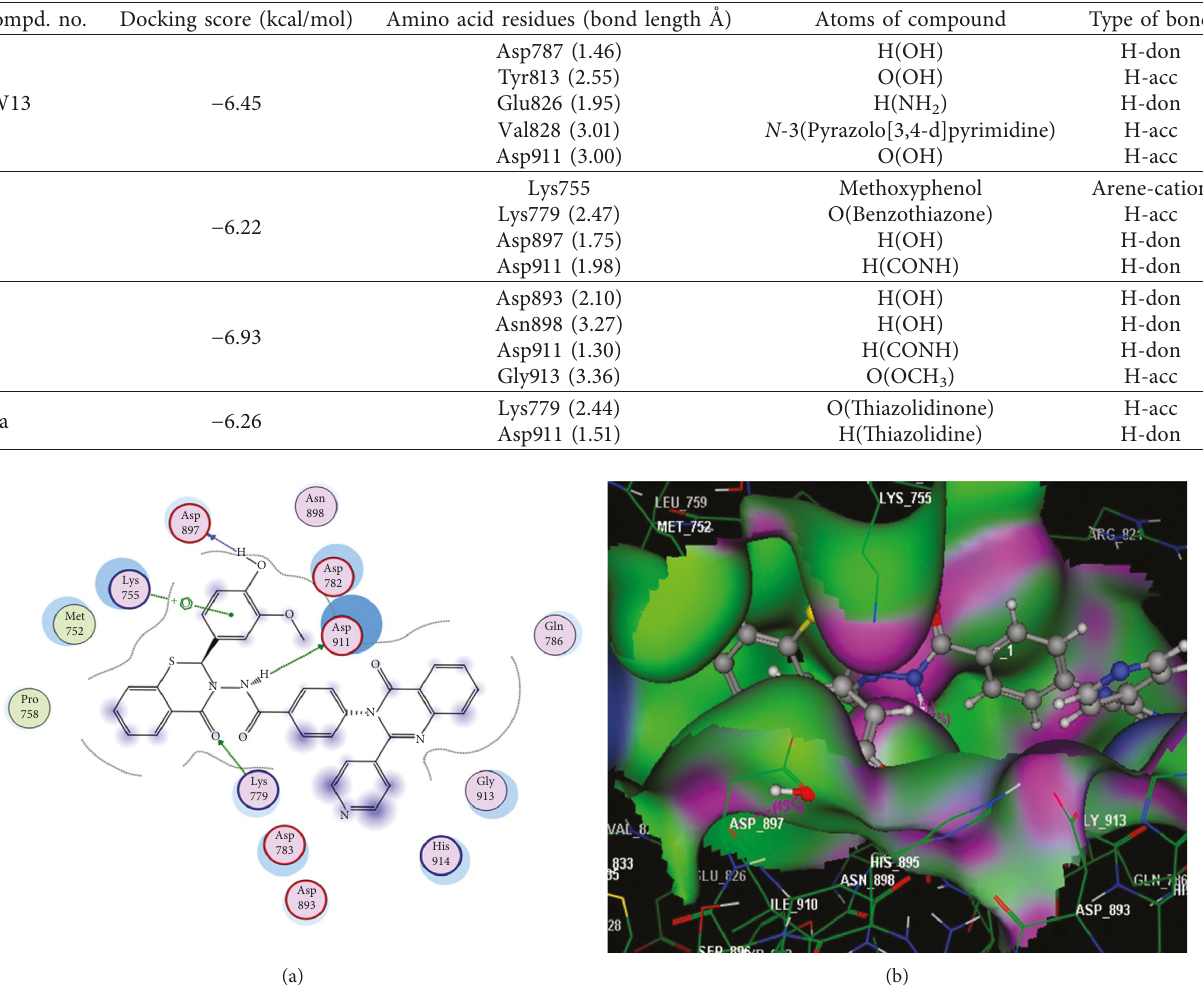
Table 4: Docking results of the synthesized compounds 9 , 12 , and 16a with PI3K in comparison with the ligand SW13. Compd. no.